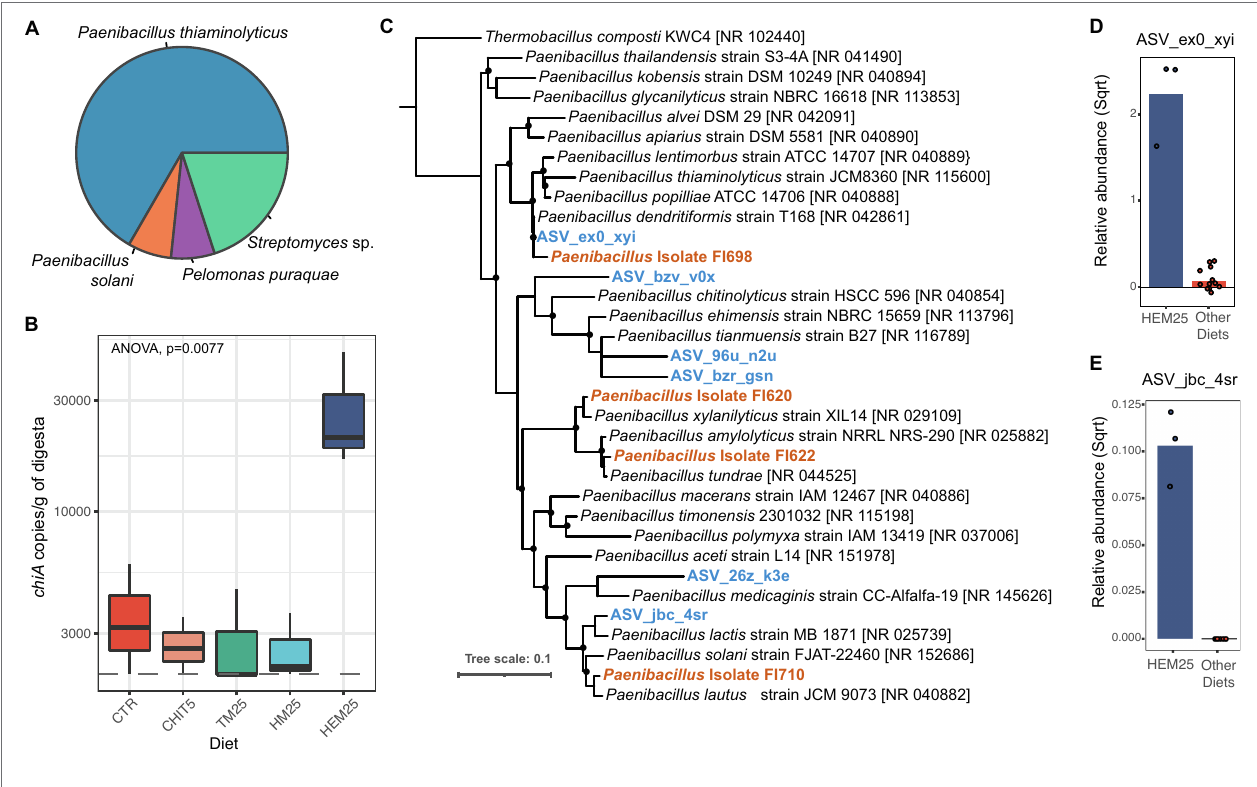
FIGURE 5 | HI exuviae diet increases the abundance of Chitinase A-encoding taxa. (A) Taxonomic affiliation of cloned chitinase genes ( chi A) amplified from digesta samples ( n = 15 sequenced clones). (B) Copy number (determined by qPCR) of chi A in DNA samples obtained from the digesta of fish fed different diets. For some of the CHIT5, TM25 and HM25 diet samples, the presence of chi A was determined to be below the limit of detection of 10 copies per μ l of DNA (equivalent to 2,000 copies per gram of digesta), represented by a dashed line. (C) Tree showing phylogenetic affiliations of ASVs and Paenibacillus sp. isolates with chitinolytic activity (recovered from the fish intestines) in relation to reference Paenibacillus isolate sequences. ASVs are presented in blue and bold, and isolates are highlighted in orange and bold. Bootstrap values >50% are presented as black filled circles on nodes. Scale bar represents 10% sequence divergence. (D,E) Relative abundance of ASV_eox_xvi (D) and ASV_jbc_4sr (E) (square root normalized) in digesta of fish fed HEM25 diet or all other diets combined. Bars represent mean values, and each point represents an individual sample ( n = 3 for HEM25 diet and n = 12 for other